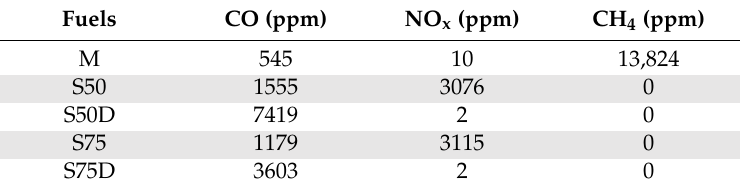
Table 5. Exhaust gas emissions measured at lean condition ( λ =